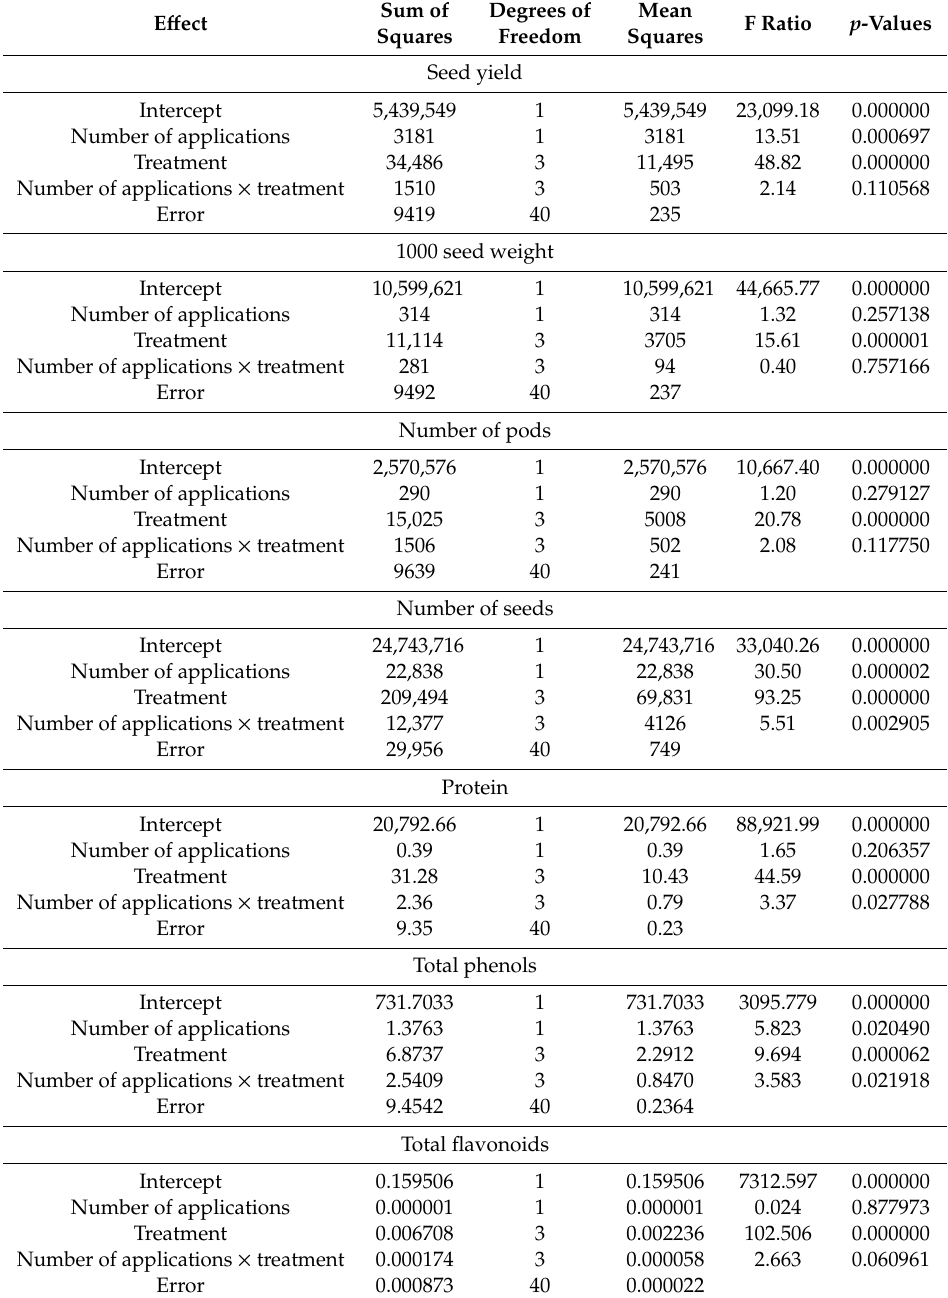
Table 3. Two-way ANOVA of number of applications and treatment of bean variety Oczko (average